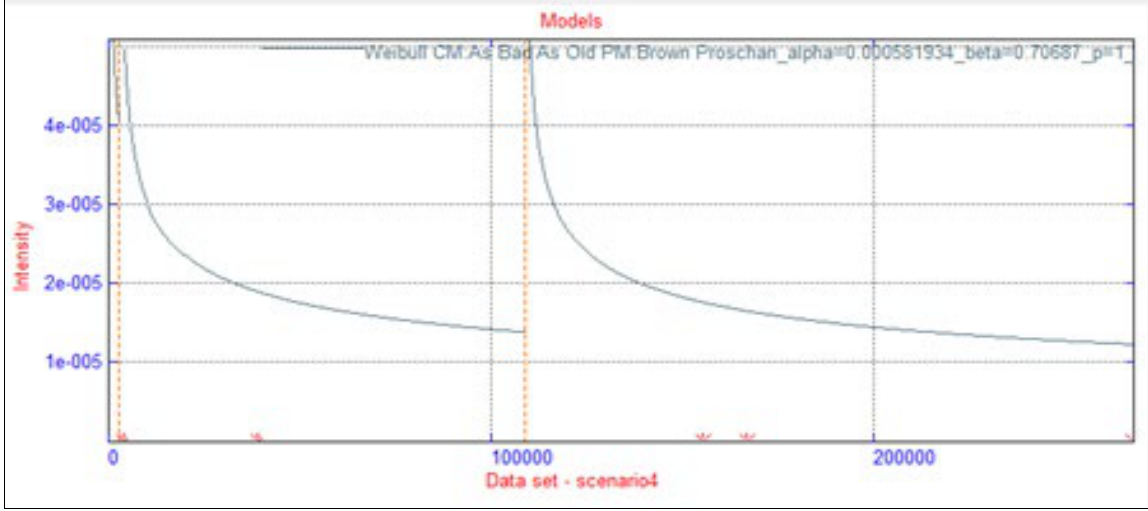
Figure 4. Failure intensity of scenario 4 for model CM ABAO – PM